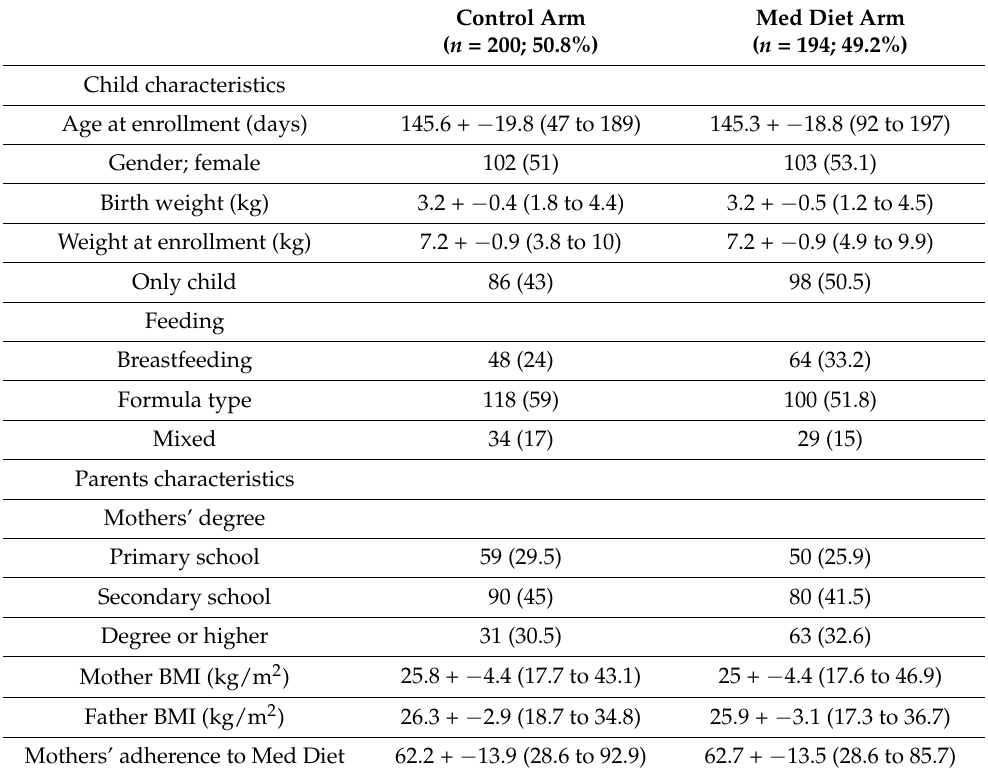
Table 1. Clinical ad demographical characteristics of the sample stratified by treatment arm. Varia- bles are described by mean ± standard deviation (min to max) or absolute frequencies (percentage).